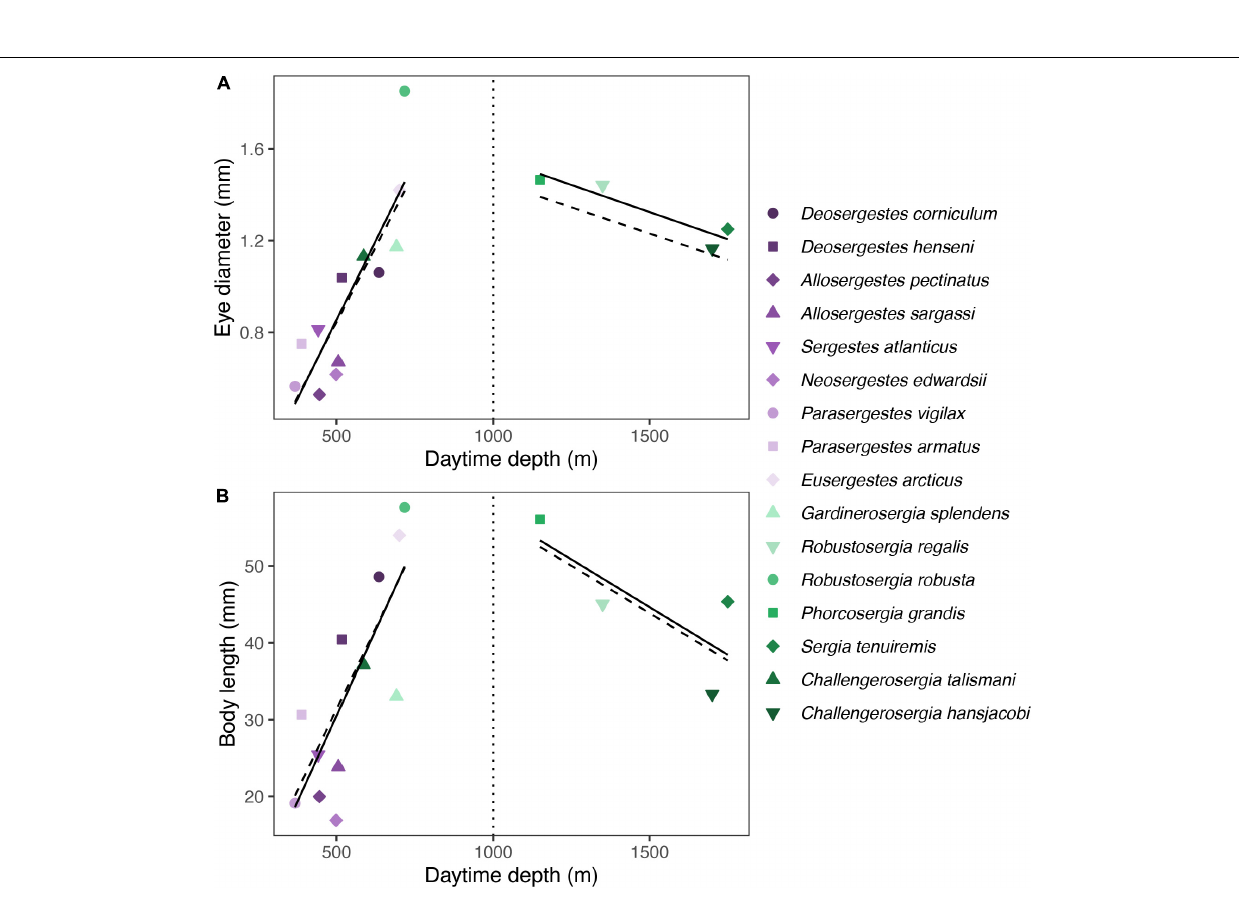
Frontiers in Ecology and Evolution |